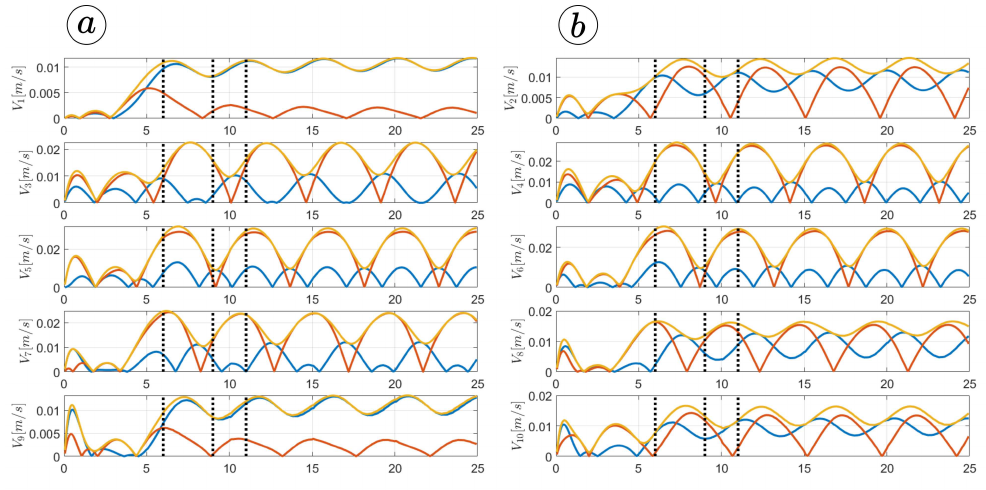
Figure 14. Velocities of the snake robot’s segments for c t = 1 ( a ) and c n = 10 ( b